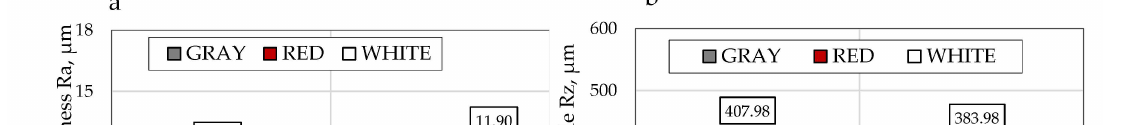
Figure 9. ( a ) Roughness ( Ra ), ( b ) maximum height of the profile ( Rz ), ( c ) surface roughness ( Sa ), and ( d ) surface maximum height of the profile ( Sz